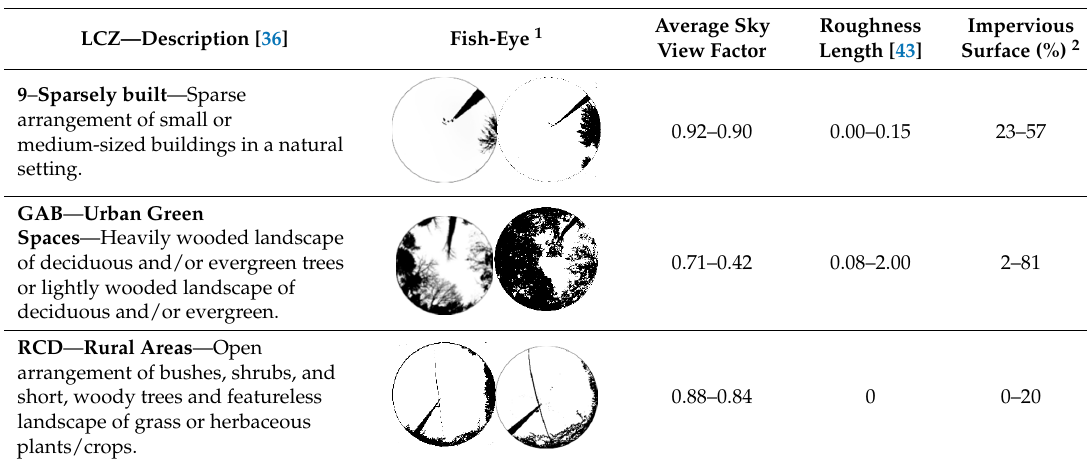
Table 2. Local Climate Zones and their attributes (Based on Stewart and Oke [36]).